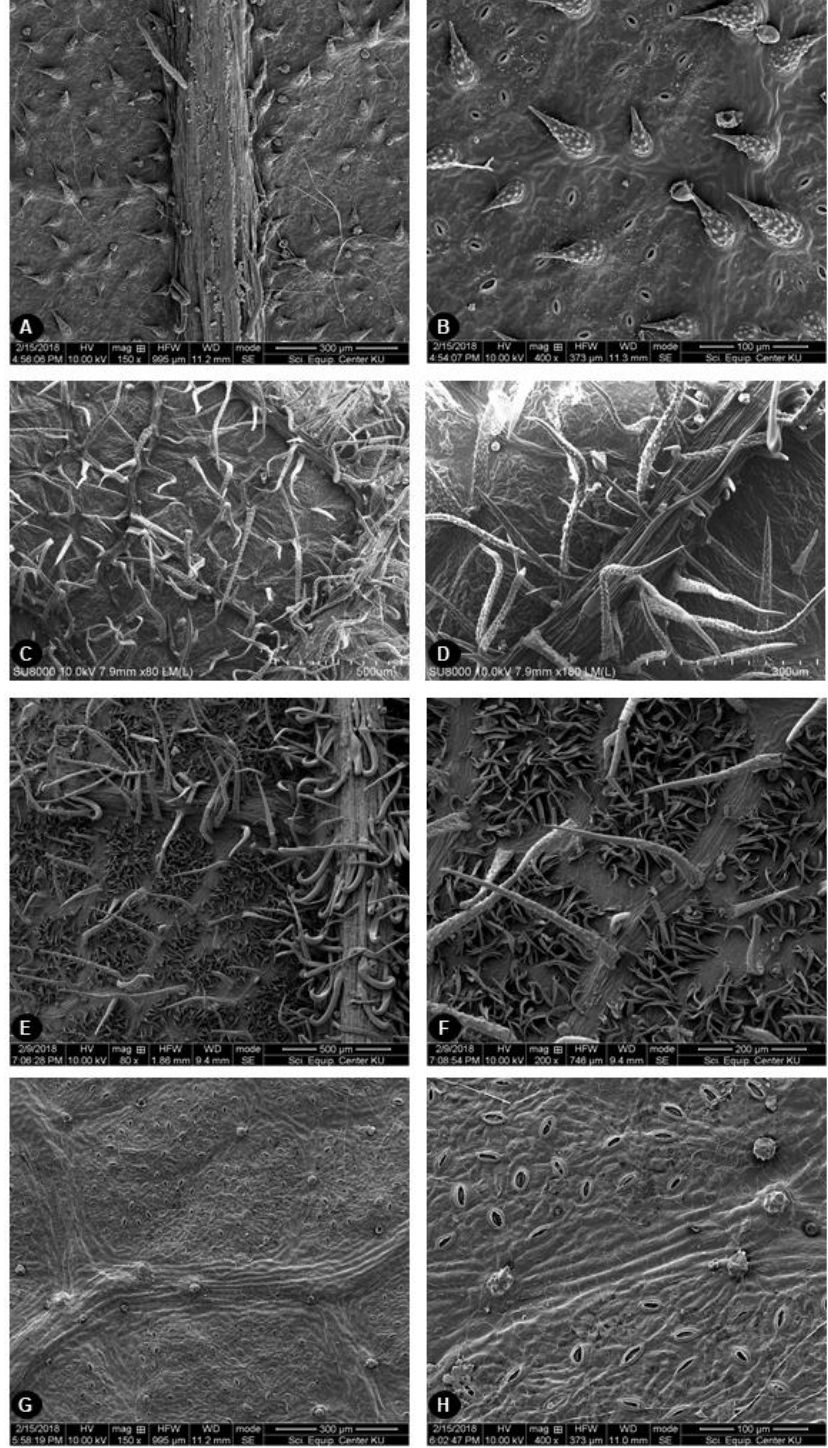
Figure 4. Lower surface of leaf micromorphology study by SEM of A. lacucha and A. thailandicus . ( A , B ) Lower surface of A. lacucha (PBM05214), gnarled papillae on the veinlets, sparsely smooth straight or uncinate hairs on lateral veins. ( C , D ) Lower surface of A. lacucha (PBM05225), gnarled long straight hairs mostly on veinlets. ( E , F ) Lower surface of A. thailandicus (PBM05229), gnarled long straight hairs mostly on the veinlets with tomentose hair in the areoles and densely smooth straight or uncinate hairs on the lateral veins. ( G , H ) Lower surface of A. thailandicus (PBM05205), gnarled papillae on the veinlets, lack of tomentose hair in the